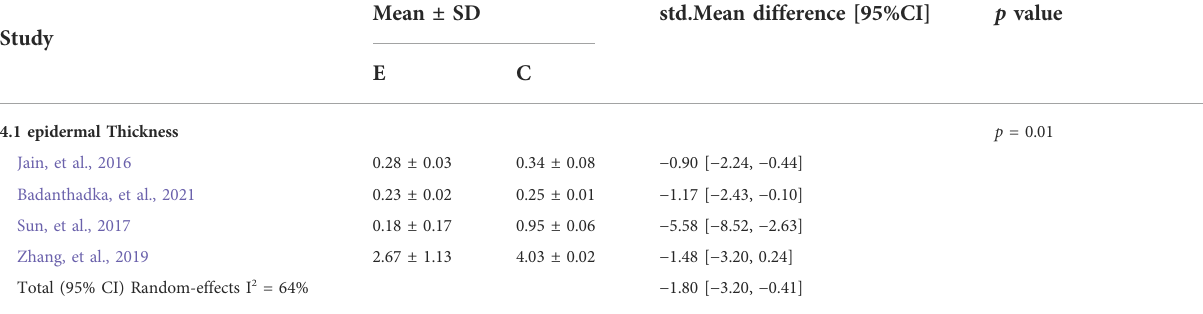
TABLE 4 Analysis of ear thickness in preclinical studies in